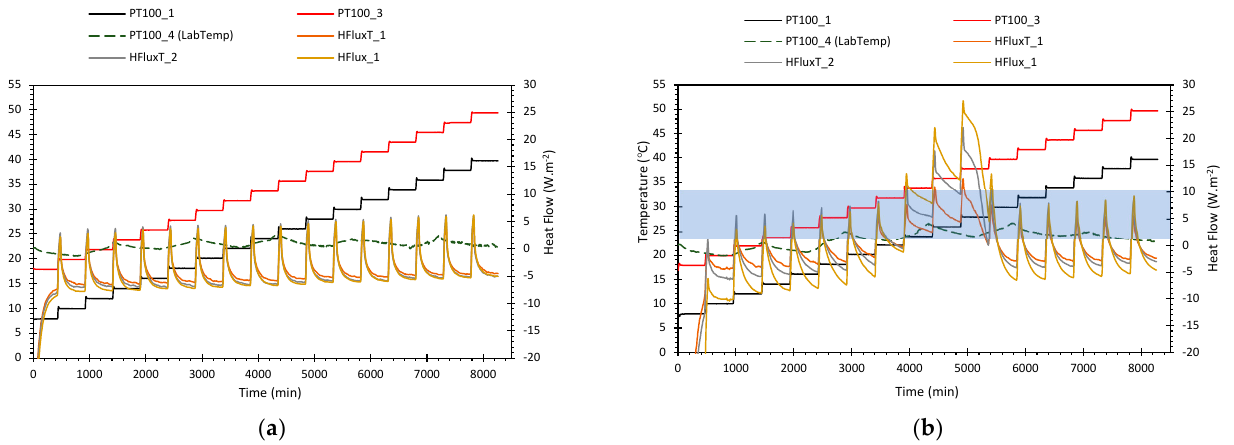
Figure 10. Hot box results: heat flux evolution when wall specimens are subjected to different temperature steps. ( a ) Reference construction solution; ( b ) enhanced construction solution with PCM macrocapsules.